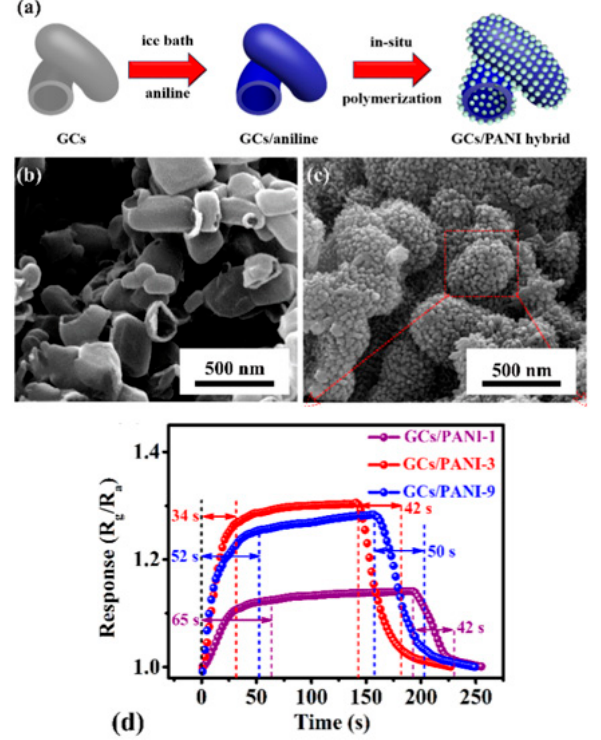
Figure 8. ( a ) Schematic illustrating the fabrication of the GCs / PANI hybrid composites. Scanning electron microscopy (SEM) images of the ( b ) pure GCs and ( c ) GCs / PANI-3 hybrid. ( d ) Dynamic response–recovery curves of the GCs / PANI-1-, GCs / PANI-3-, and GCs / PANI-9-based sensors toward 10 ppm NH 3 . Reproduced from Wang, H.; Nie, S.; Li, H.; Ali, R.; Fu, J.; Xiong, H.; Li, J.; Wu, Z.; Lau, W. M.; Mahmood, N.; Jia, R.; Liu, Y. and Jian, X., 2019.3D Hollow Quasi-Graphite Capsules / Polyaniline Hybrid with a High Performance for Room-Temperature Ammonia Gas Sensors, ACS Sens., 4, pp. 2343–2350 [120].